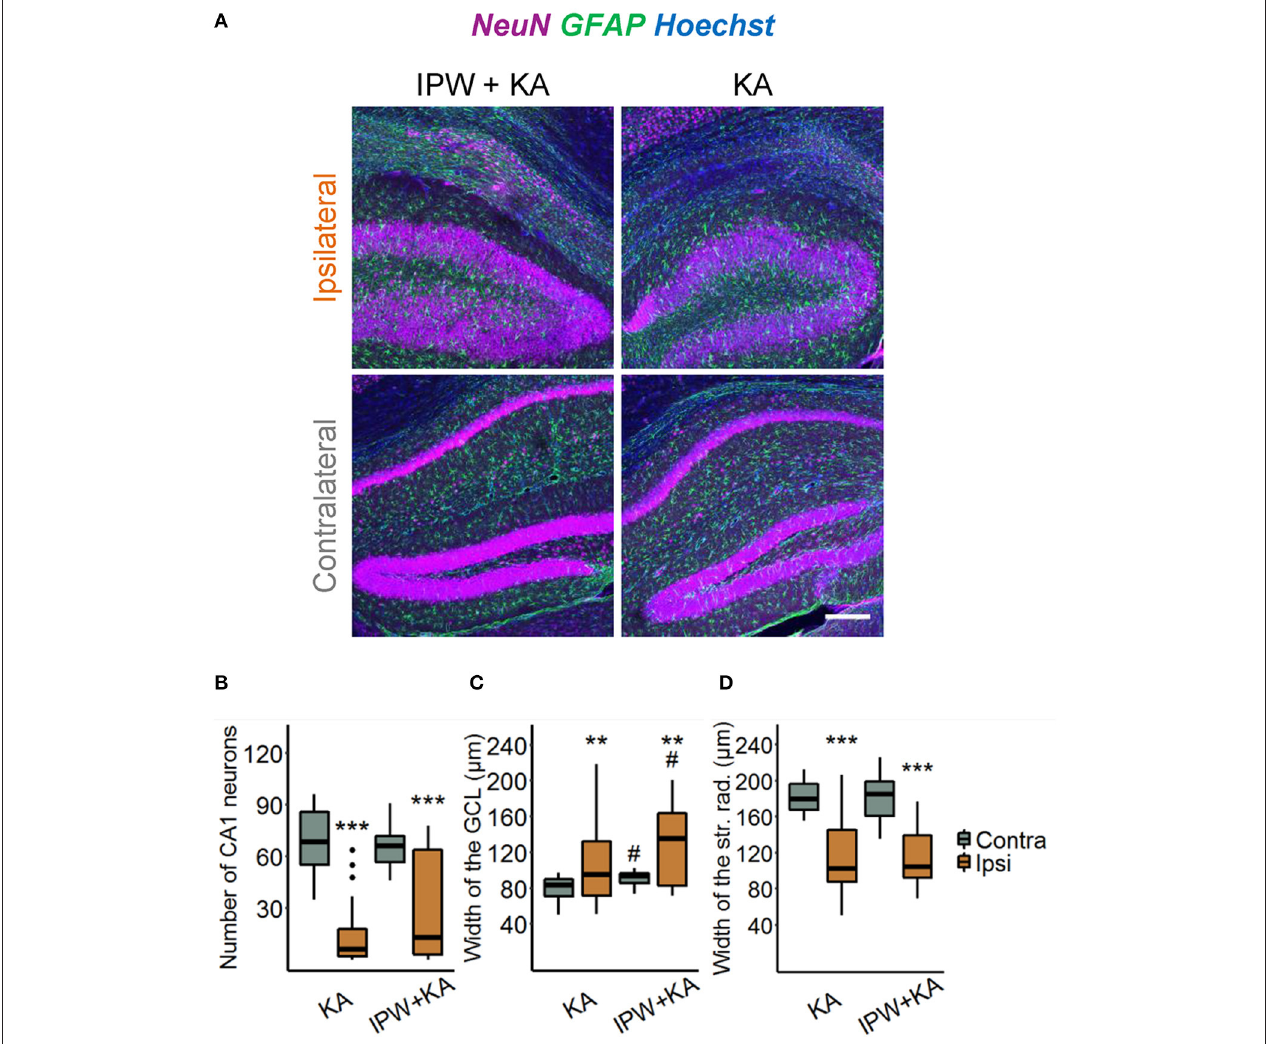
FIGURE 5 | IPW-5371 treatment has no effect on the development of HS in experimental TLE. (A) Representative maximum intensity projections of combined NeuN (magenta), GFAP (green), and Hoechst (blue) staining in ipsi- and contralateral hippocampal slices from IPW-5371- and vehicle-treated kainate mice 1 month after kainate injection. Scale bar: 200 µ m. Hippocampi of both IPW-5371- and vehicle-treated kainate mice displayed similar (B) pyramidal cell loss in the CA1 region, (C) GCD in dentate gyrus, and (D) shrinkage of the CA1 stratum radiatum . Data display box plots representing median and quartiles. *** p < 0.001 vs. contralateral, ** p < 0.01, # p < 0.05 vs. control (two-way ANOVA). N = 29–31 slices from six animals/condition. CA, cornu ammonis; GCL, granule cell layer; str. rad., stratum radiatum